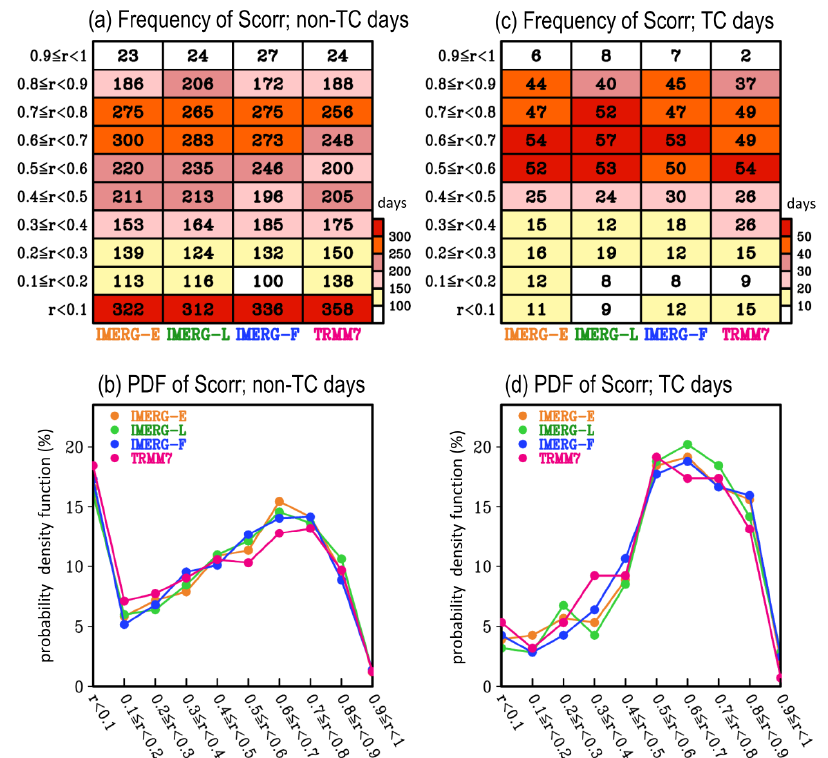
Figure 4. (a) Occurrence frequency of Scorr between CWB and selected SPPs ( x -axis) for non-TC days during 2000 – 2018 JASO, and for different ranges of Scorr values (denoted as r). Corresponding to ( a ), ( b ) is the Scorr-related probability density function for non-TC days. ( c , d ) is similar to ( a , b ), respectively, but for the statistical values that estimated from TC days during 2000 – 2018 JASO. Table 4. Accumulated number and percentage (%) of days in Figure 4 with Scorr values ≥ 0.5. Highest values are bold.